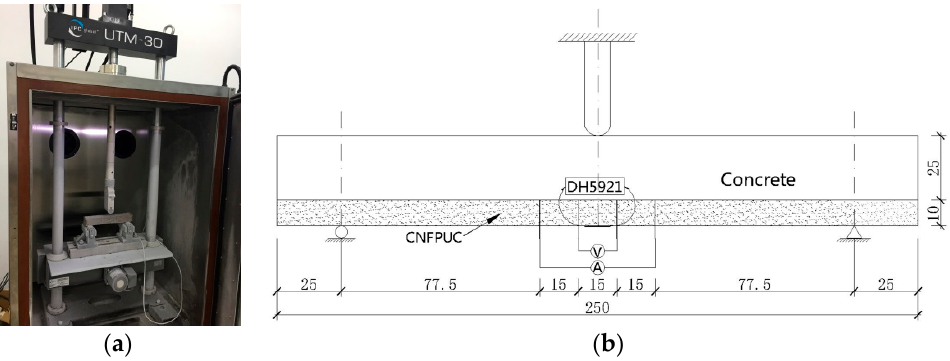
Figure 3. Bending test. ( a ) Bending test loading diagram; ( b ) four-electrode method